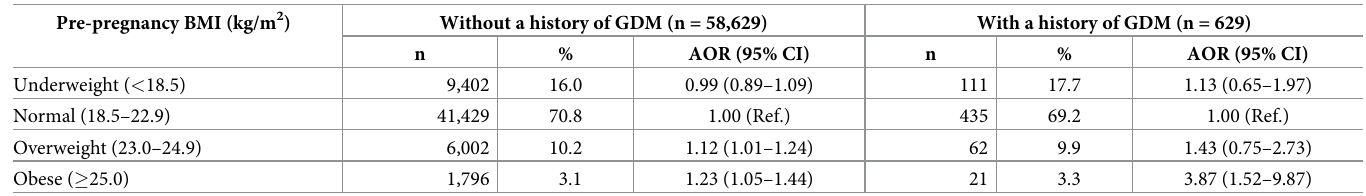
Table 3. Association between pre-pregnancy BMI and type 2 diabetes according to the status of GDM history in the Health Examinee Study (HEXA) 2004–2013. Pre-pregnancy BMI (kg/m 2 )